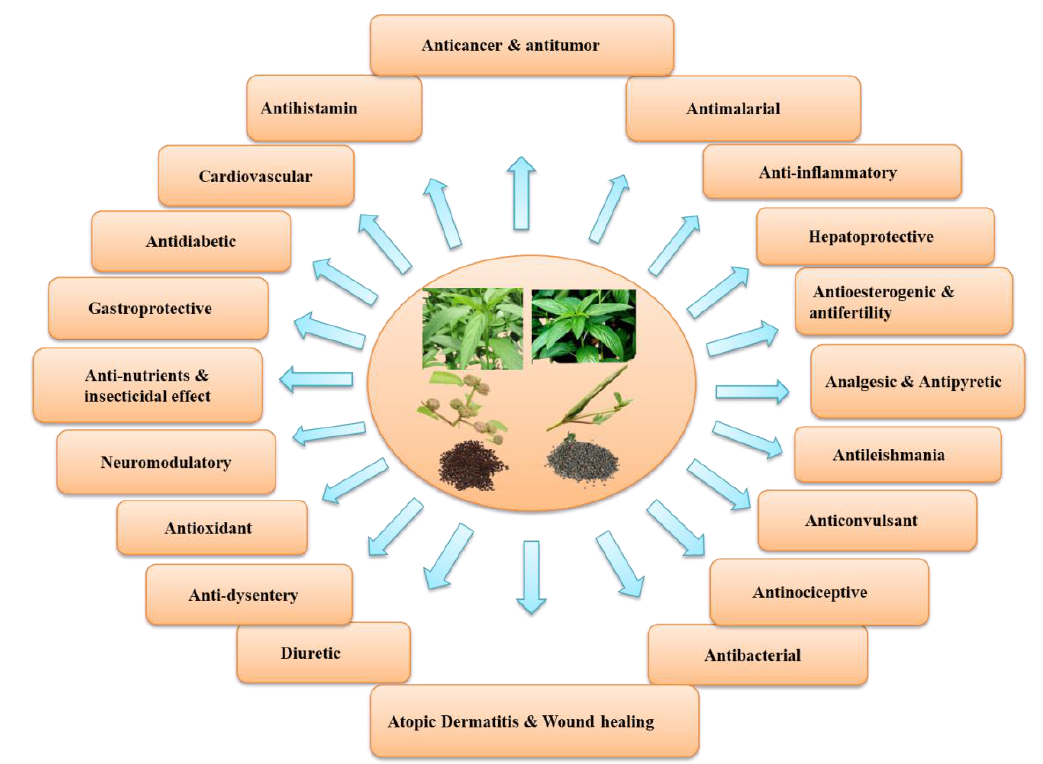
Figure 2. An overview of various biological, pharmacological, and medicinal attributes of C. capsularis and C. olitorius